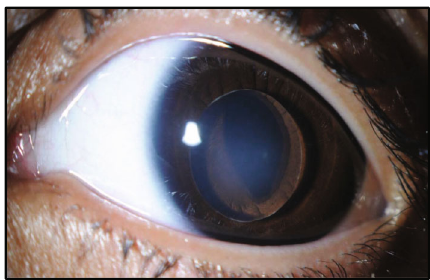
Figure 1: Slit lamp photograph of the left eye showing megalocornea and microspherophakia with lens dislocation in the anterior chamber and ectropion